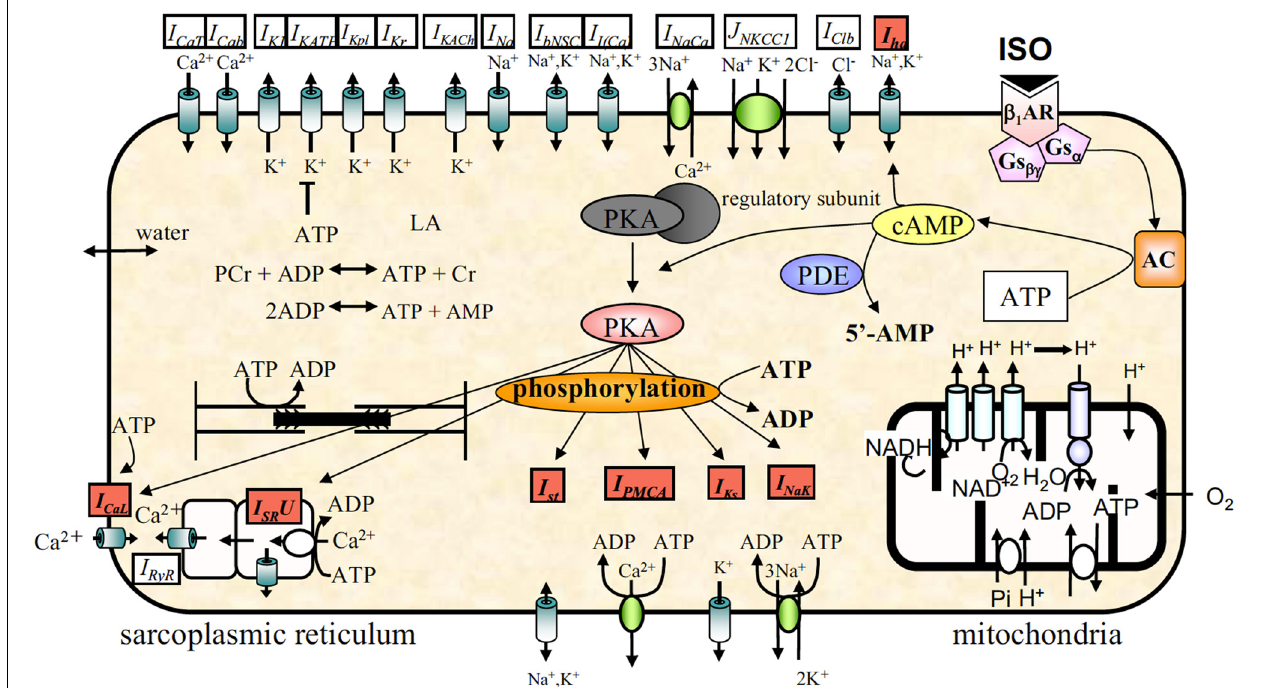
FIGURE 10 | Model schematic of a SAN cell model with integrated β AR system, figure modified from (52).